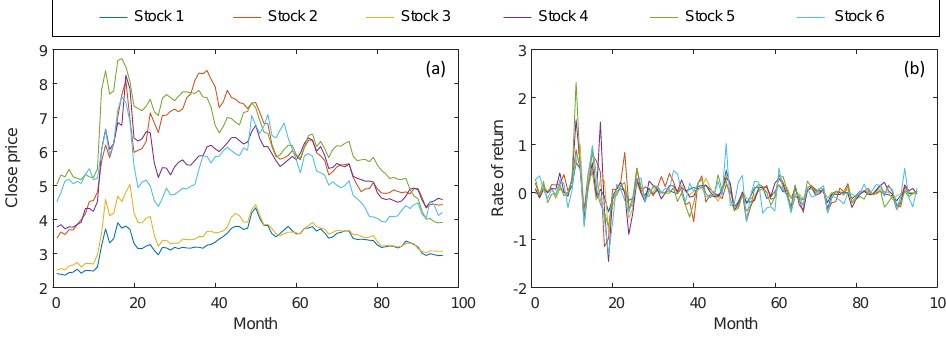
Figure 4. The stock data for 6 portfolios used: ( a ) close price data, ( b ) rate of